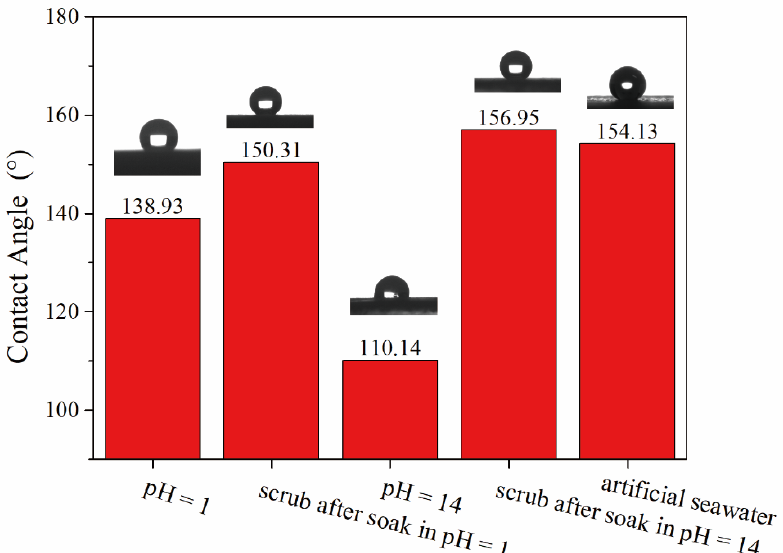
Figure 8. Durability study of coatings in different solutions.